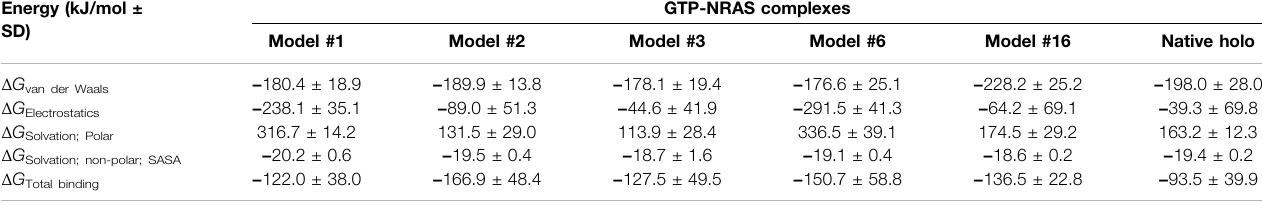
TABLE 6 | The MM-PBSA-calculated total binding-free energy and its constituting energy terms. Energy (kJ/mol ± SD)